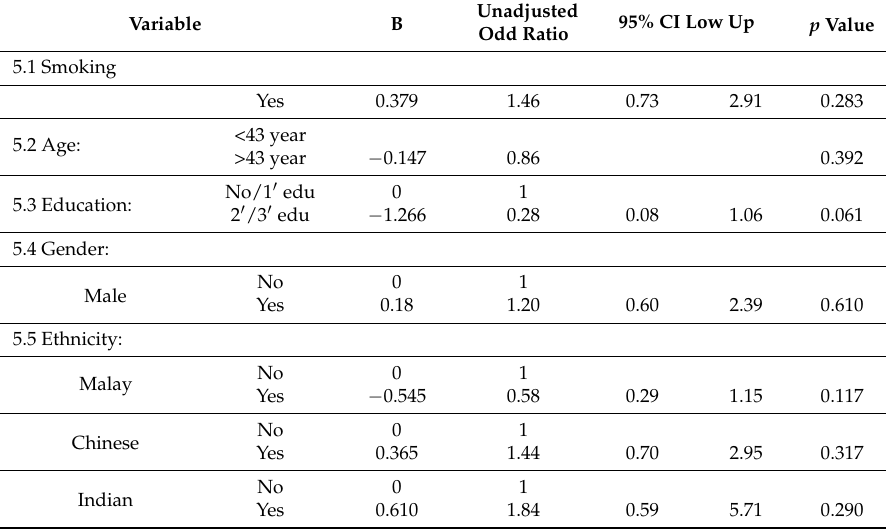
Table 4. Association factors of metabolic syndrome in patients with